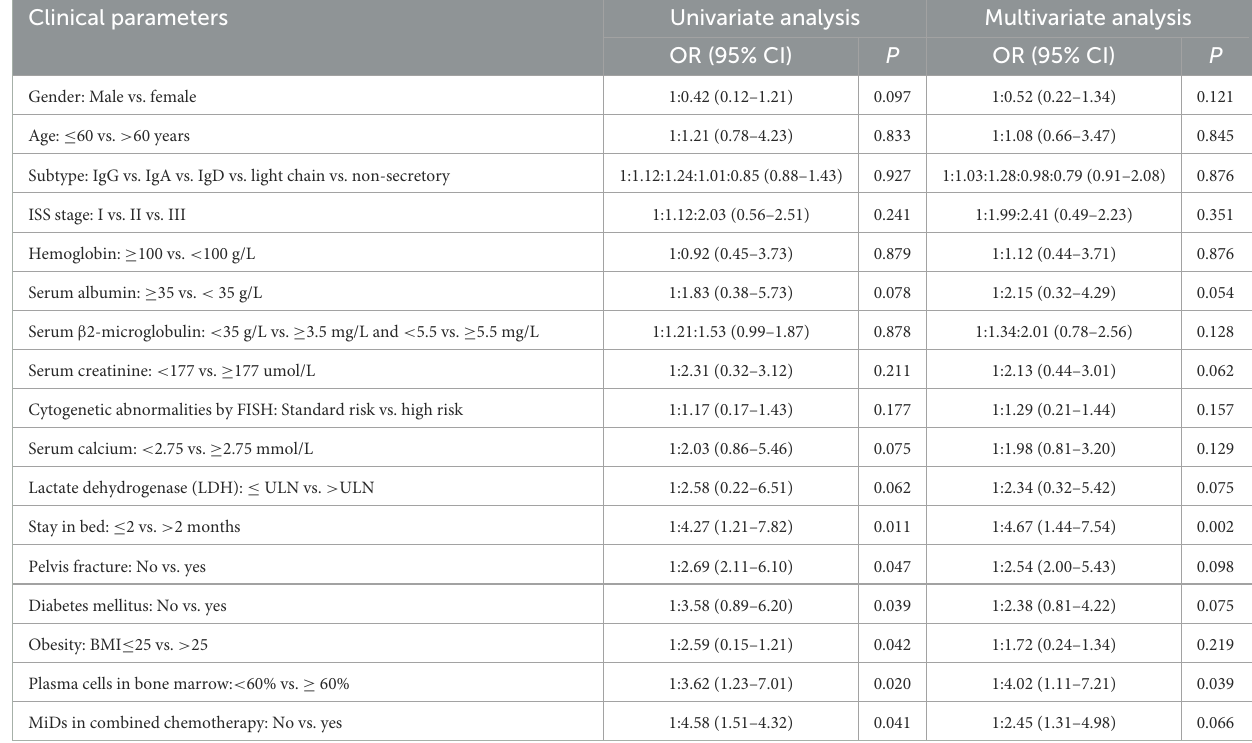
TABLE 1 Risk factors of thrombosis of newly diagnosed multiple myeloma under the thromboprophylaxis according to the risk assessment model (RAM). Clinical